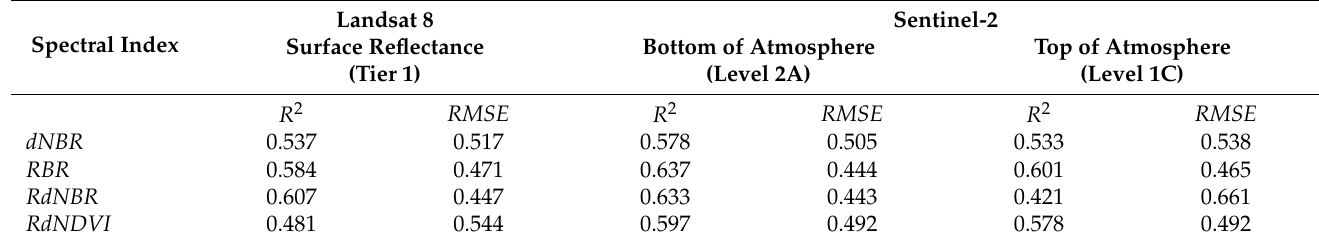
Table 5. Paired scene method model fit ( R 2 ) and normalized root-mean-square error ( RMSE ) for non-linear least squares regression between composite burn index (CBI) plots and remotely sensed burn severity estimates using either Landsat or Sentinel imagery. Results from Sentinel imagery are presented both for atmospheric and terrain corrected Bottom of Atmosphere (BOA) and uncorrected Top of Atmosphere (TOA) scenes. Models were fit to the combined dataset of 912 CBI plots from all 26